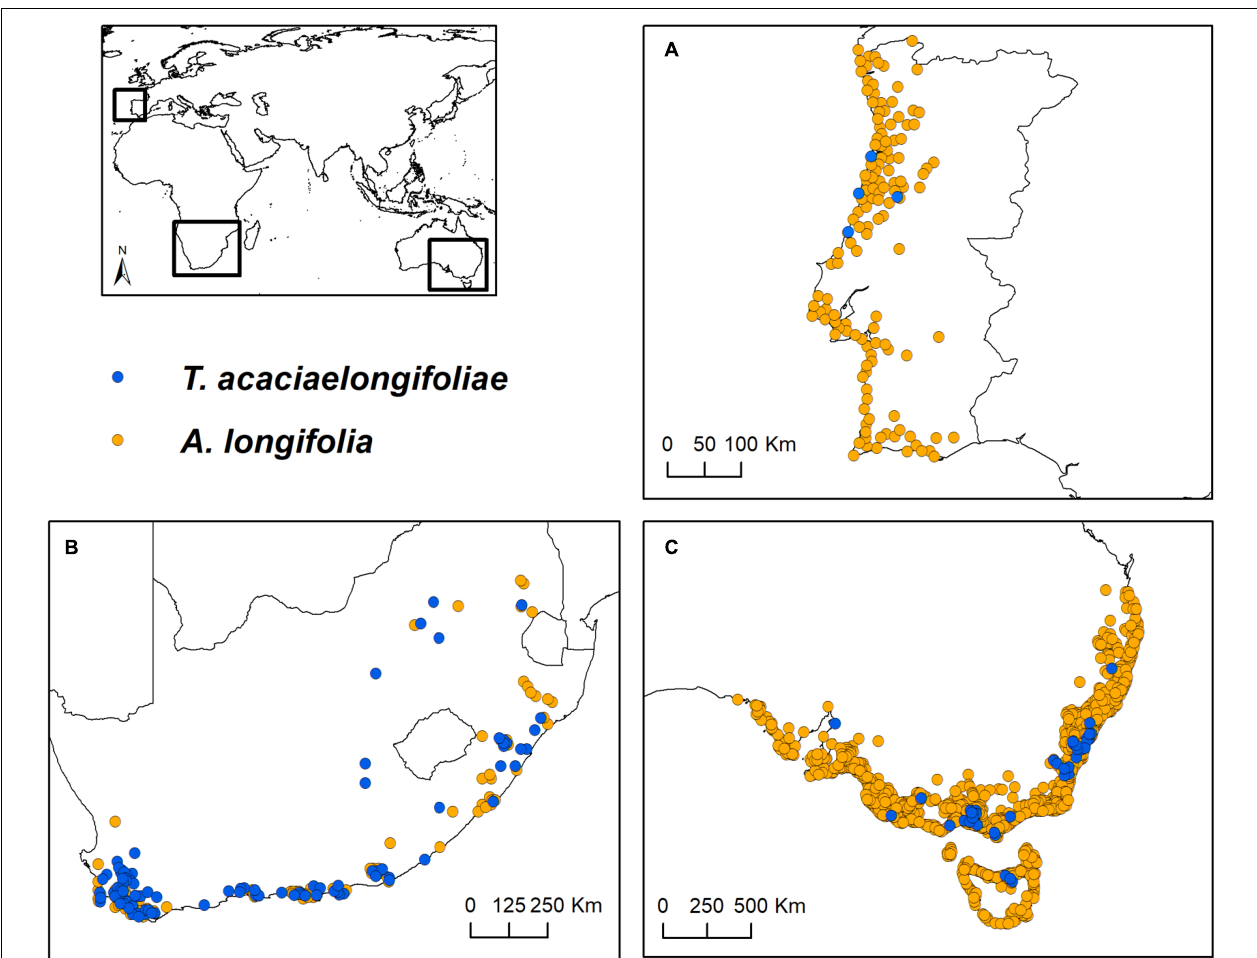
FIGURE 1 | Study areas and occurrence records of Acacia longifolia and Trichilogaster acaciaelongifoliae used in this work. (A ; top right): Portugal; (B ; bottom left): South Africa; and (C ; bottom right): southeastern Australia. Trichilogaster acaciaelongifoliae records from Portugal are merely indicative and were not included in any analyses due to their low number and recent